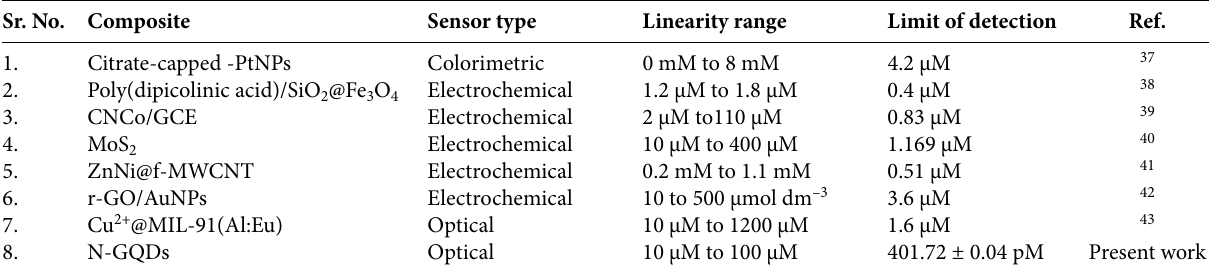
Table 1: Summary of different types of sensors for detection of UA Sr. No. Composite